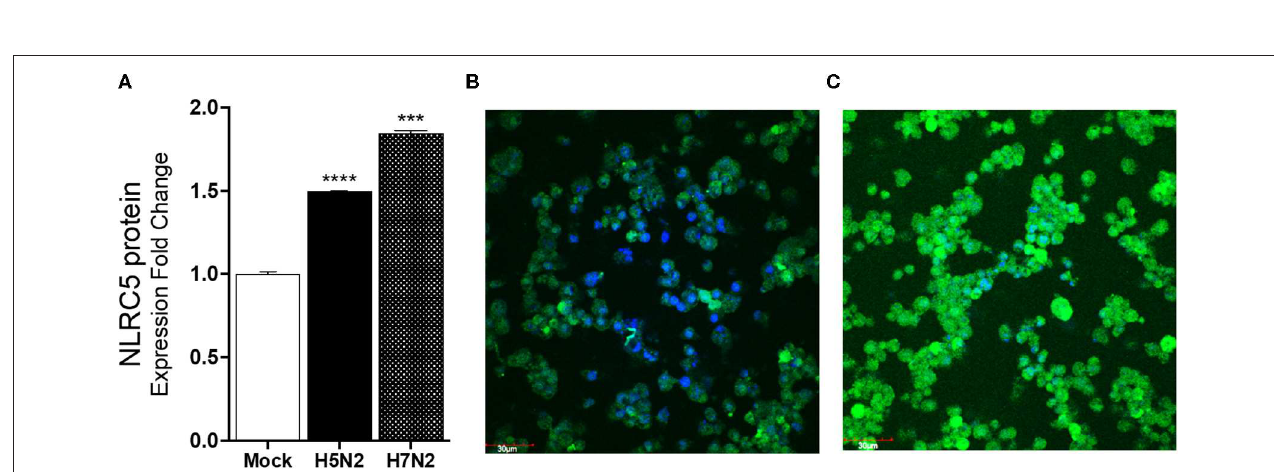
FIGURE 3 | NLRC5 protein is increased in LPAIV-infected chicken macrophages. Chicken macrophage MQ-NCSU cells were infected with the H7N2 or H5N2 AIVs for 24h. (A) NLRC5 protein was quantified using ELISA. (B) Fluorescence photomicrographs of (B) mock-infected cells stained for NLRC5 and (C) LPAIV H5N2-infected macrophage cells. The blue color represents DAPI-nuclei specific staining and the green color represents FITC-NLRC5 specific staining. Data points are mean of three biological replicates with error bars showing standard deviation. *** p ≤ 0.001, **** p ≤ 0.0001.